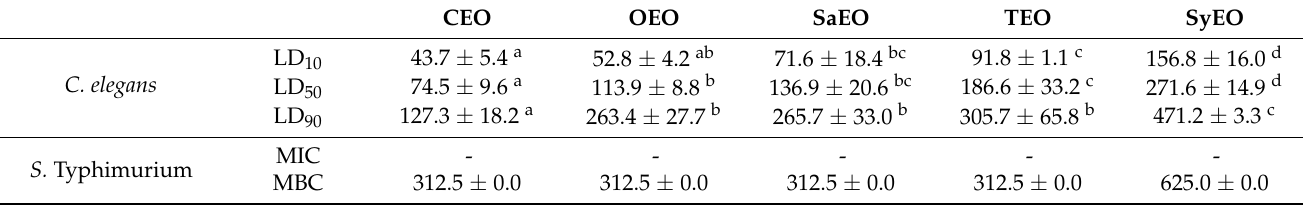
Table 2. Evaluation of the toxicity of essential oils on Caenorhabditis elegans and the pathogen Salmonella enterica sv. Typhimurium. Values in µ g/mL are means ± SD ( n = 6). Values with different letters in the same line are significantly different ( p <